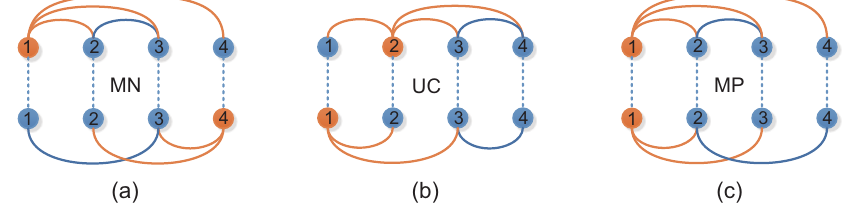
Figure 2. Schematic illustration of three kinds of correlated structure, maximally negative ( a ), uncorrelated ( b ) and maximally positive ( c ). The nodes and edges that are failure under HLD strategy are shown in